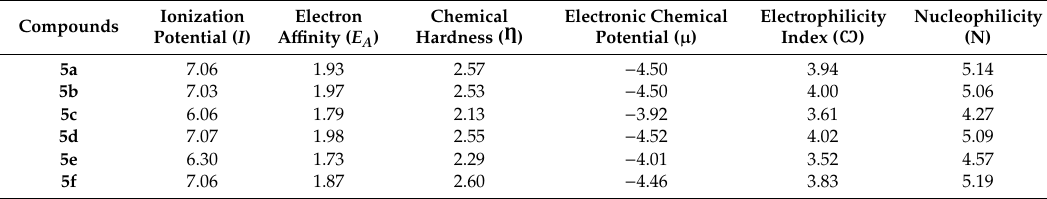
Table 3. Ionization potential ( I ), electron affinity ( E A ), chemical hardness ( Ƞ ), electronic chemical potential ( μ ), electrophilicity index ( Ꙍ ), and nucleophilicity (N) of compounds ( 5a – f ). All values are given in eV.